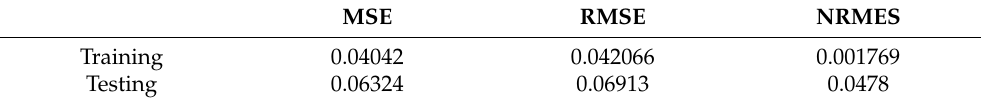
Table 9. Results of the LSTM model’s performance in predicting the prices of the XRP cryptocurrency. MSE